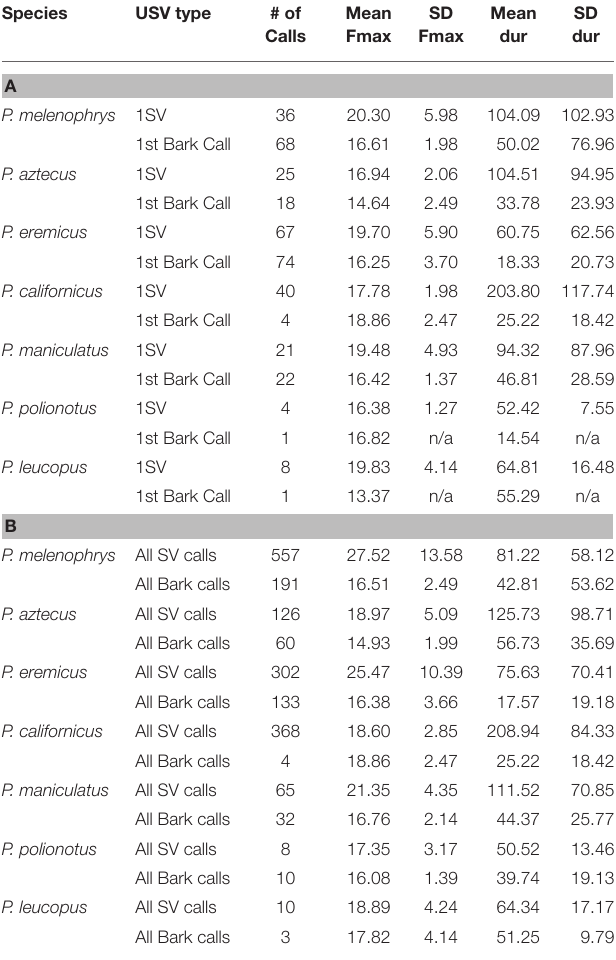
TABLE 1 | Mean ( ± ) SD values for USV calls recorded from seven species at the Peromyscus Genetic Stock Center in 2006.